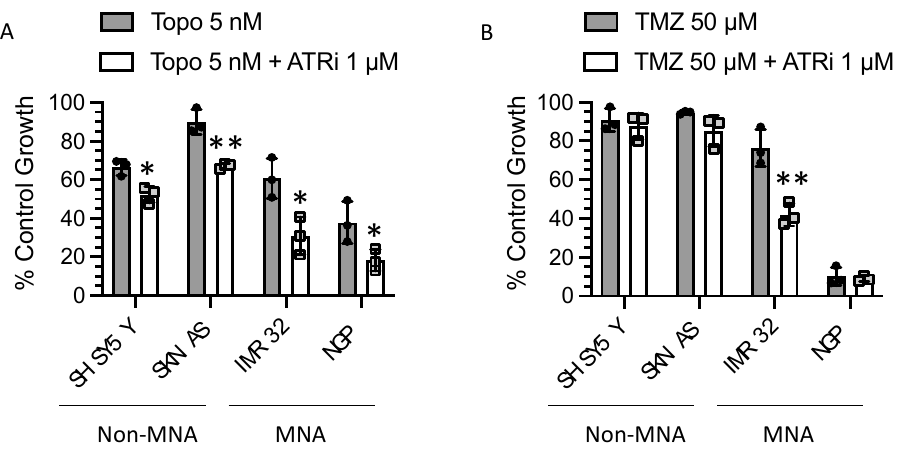
Figure 7. ATRi sensitise MYCN-amplified (MNA) and non-amplified (non-MNA) cells to topotecan and temozolomide. Effect of 1 µ M VE-821 (ATRi) on growth inhibition of ( A ) 5 nM topotecan (Topo) and ( B ) 50 µ M temozolomide (TMZ) normalised to the effect of VE-821 alone and measured by XTT cell proliferation assay. Data shown are the mean + standard deviation of 3 individual experiments. Student’s t -test: * p < 0.05, ** p < 0.01 comparing TMZ to TMZ + ATRi in each cell line.